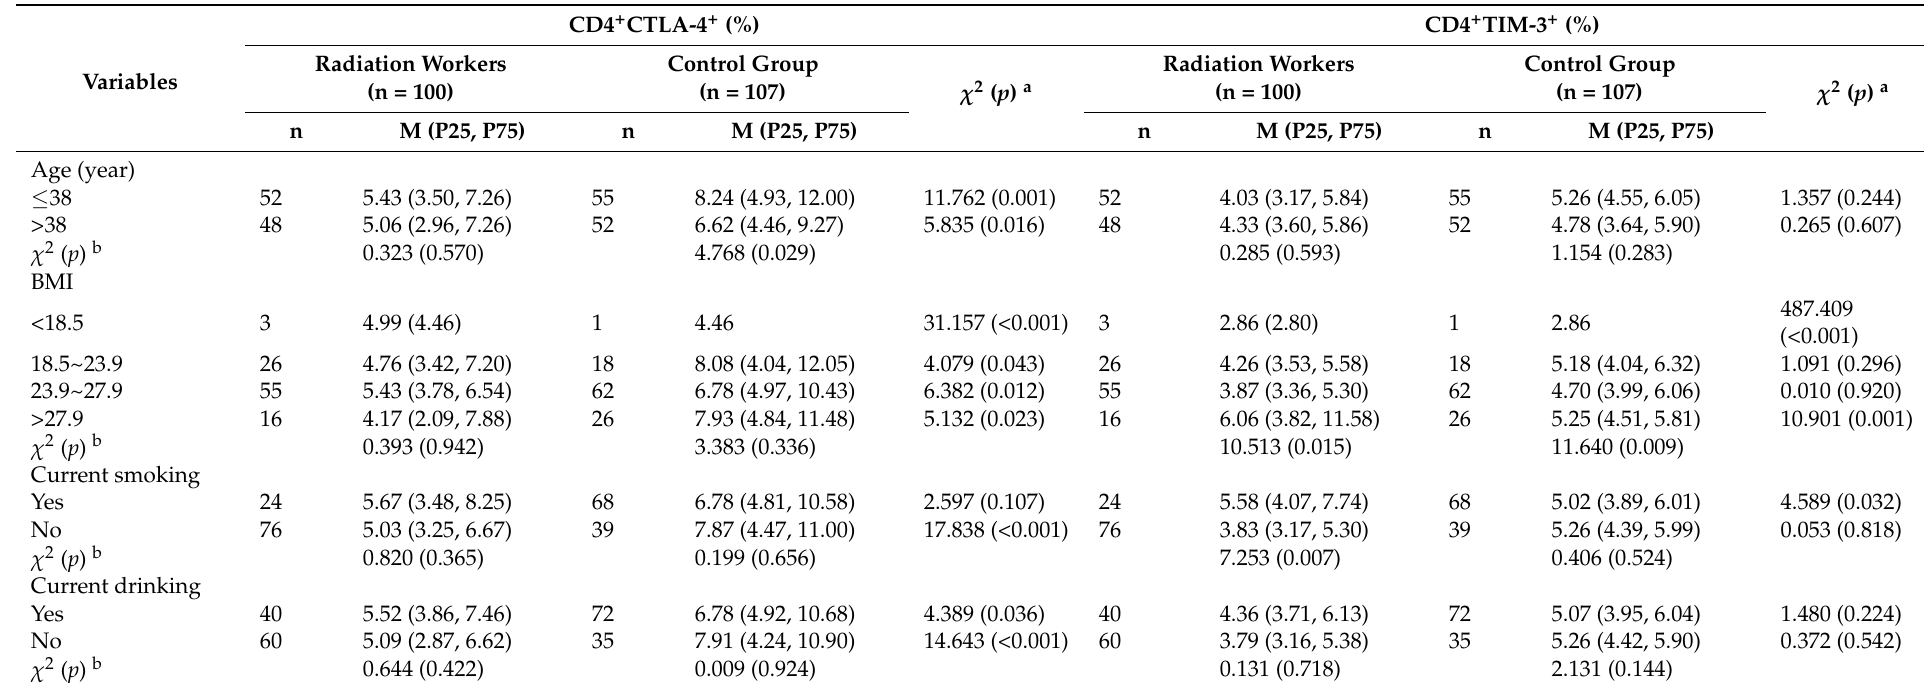
Table 6. Relationship between demographic characteristics and the expression of CTLA-4 and TIM-3 in